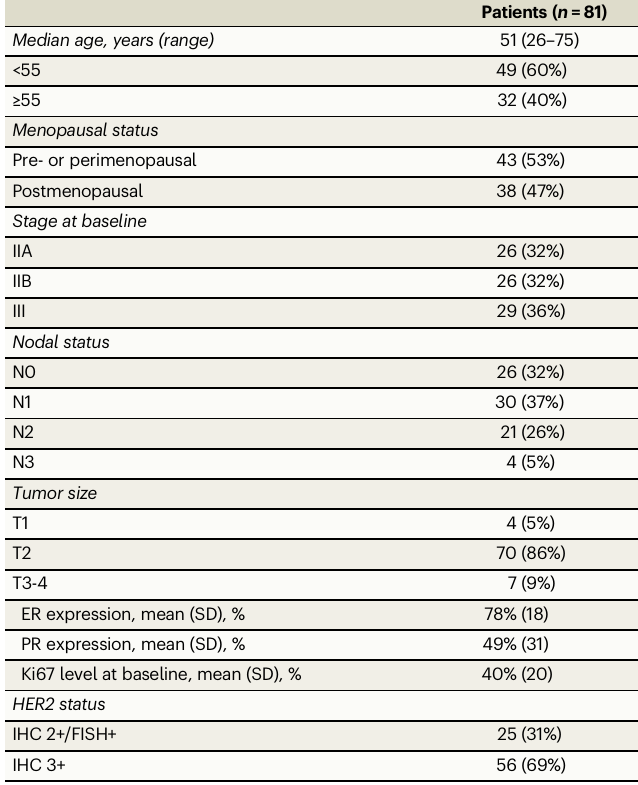
Table 2 | Pathological and clinical Patients ( n =81)